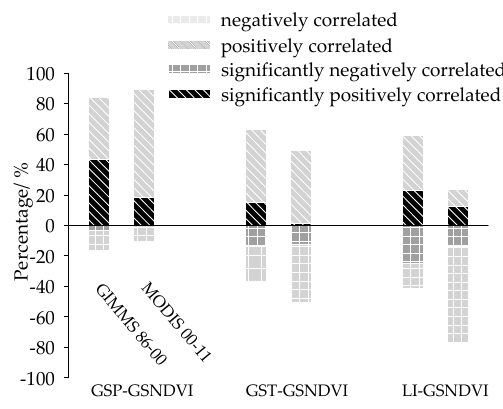
Figure 5. The percentage of pixels with positive and negative partial correlation coefficients indicating the determination of each environmental factor on the growing season NDVI (GSNDVI).